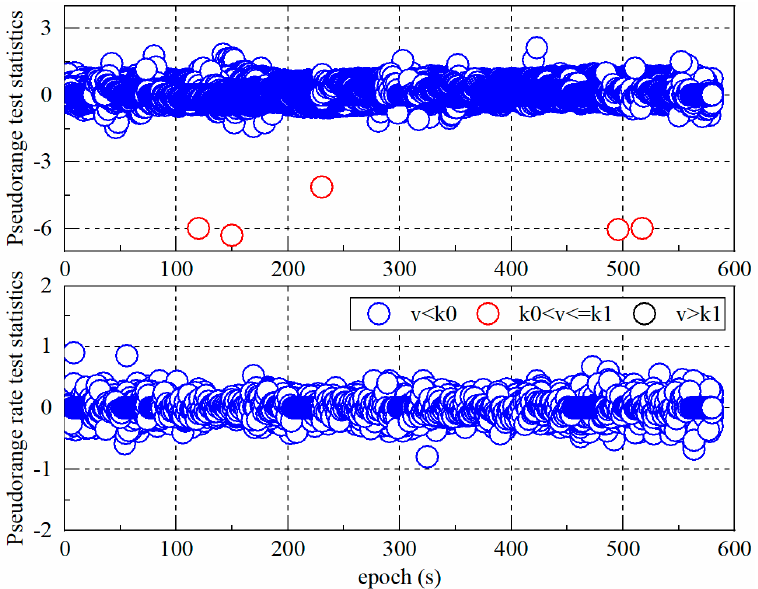
Figure 11. Standardized prediction residual sequence of dual ‐ system (GPS + BDS) dual ‐ antenna GNSS/MIMU tightly coupled integration using the SVD ‐ RACKF scheme.